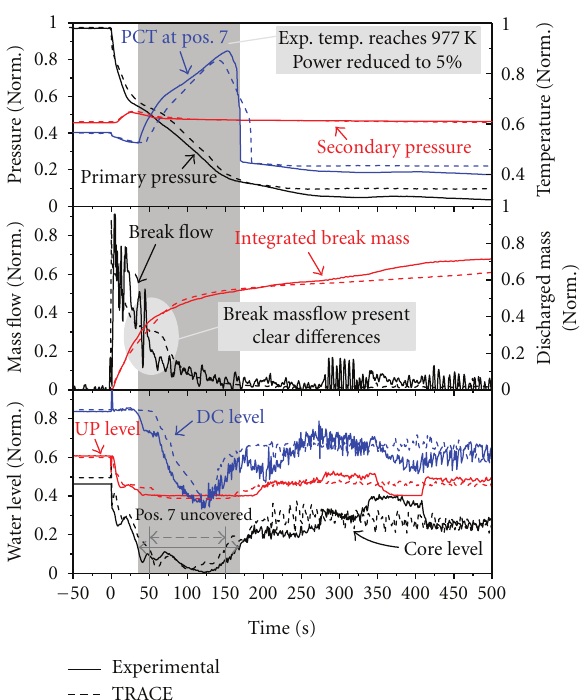
Table 9: Chronology of the main events in Test 2 [13].